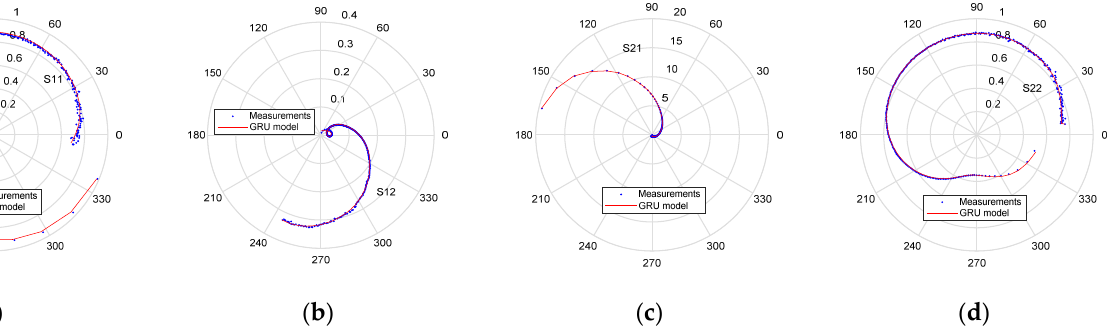
Figure 15. Measured (blue symbols) and GRU simulated (red lines) behavior of ( a ) S 11 , ( b ) S 12 , ( c ) S 21 , and ( d ) S 22 with the frequency range spanning from 200 MHz to 65 GHz for the DUT at V DS = 30 V, V GS = − 3.1 V, and T a = 90 °C.